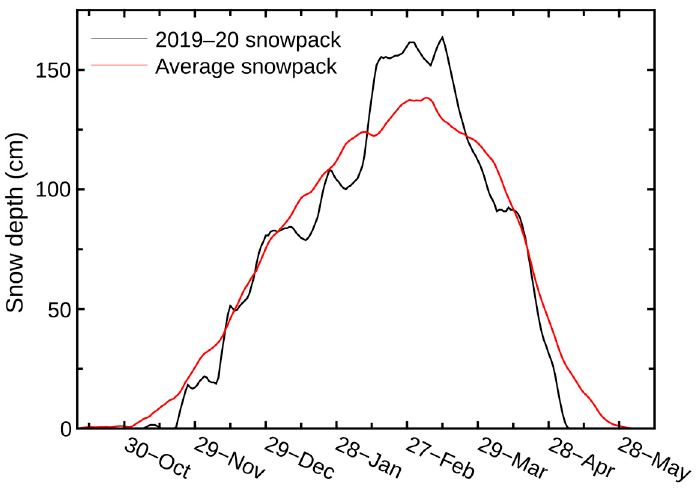
Figure 4. Snowpack of 2019–2020 and average snowpack trend, 1981–2010, for the Natural Resources and Conservation Service snow telemetry site at Moscow Mountain (Site #989) [53].